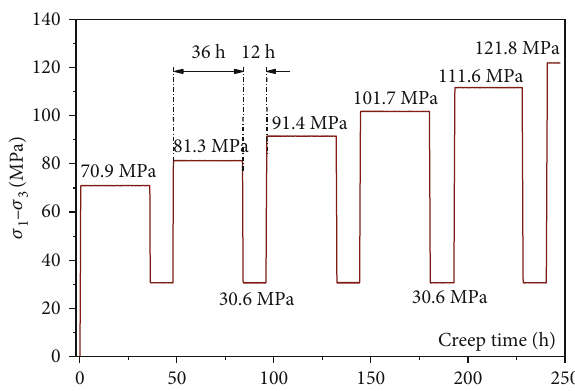
Figure 2: Multilevel loading and unloading stress path applied in the triaxial creep